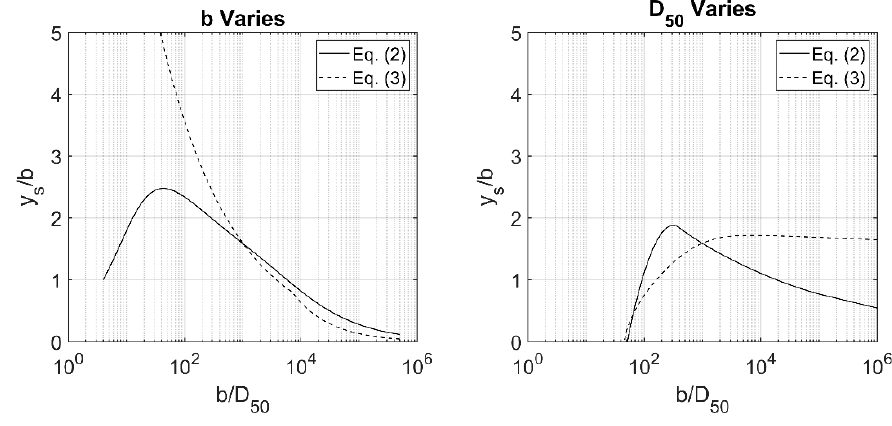
Figure 2. Predicted equilibrium scour depth using the FDOT and Oh [18] formulations.